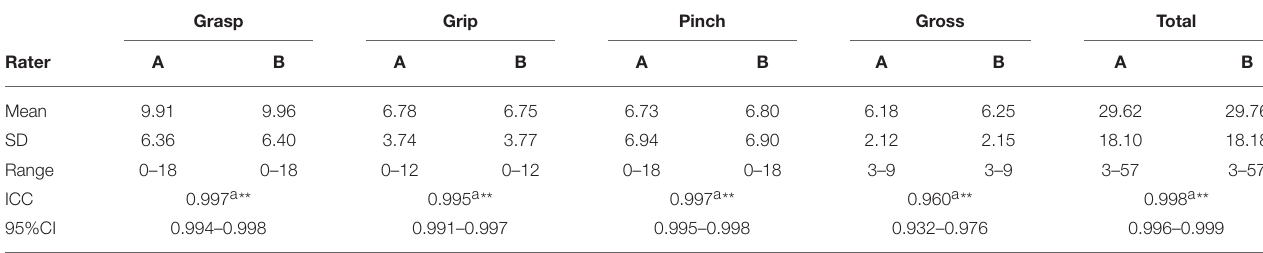
TABLE 2 | C-ARAT inter-rater reliability.